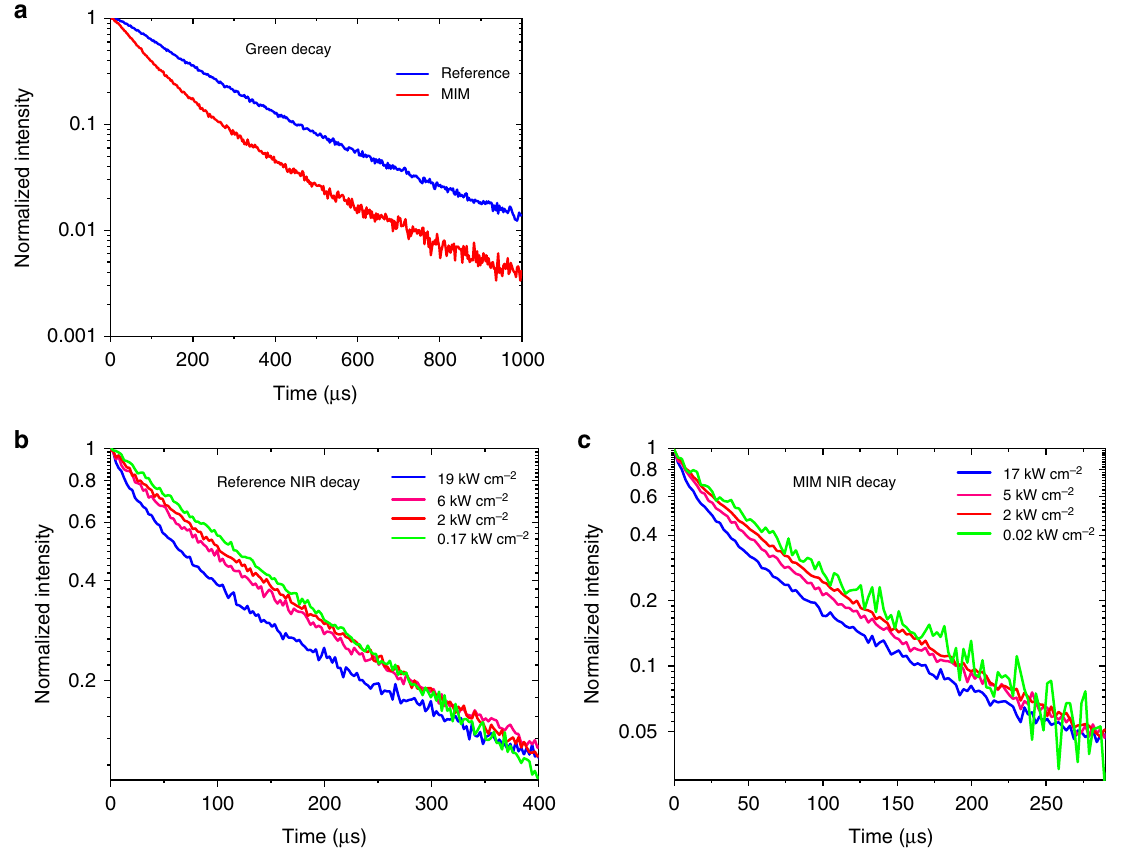
Fig. 4 Transient photoluminescence spectroscopy results. a Green emission decay curve under 980 nm excitation for 250 nm diameter metal – insulator – metal (MIM) sample and reference. The MIM decay is faster due to quenching from the metal layers. b Near infrared (NIR) decay curve for reference sample at various excitation power densities. As the excitation power density increases, the NIR decay rate decreases due to an increase in the upconversion process. c NIR decay curve for 250nm MIM sample. The MIM sample shows a similar trend with higher power densities resulting in lower decay rates. At lower power densities, the intrinsic decay process